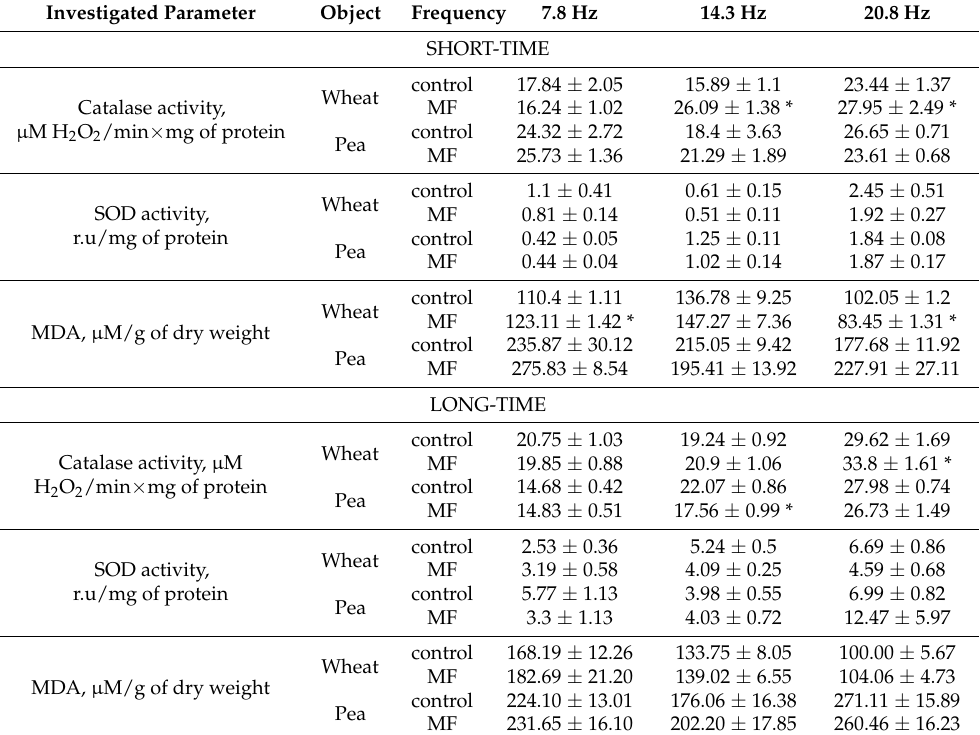
*—a statistically significant difference from control ( p ≤ 0.05).